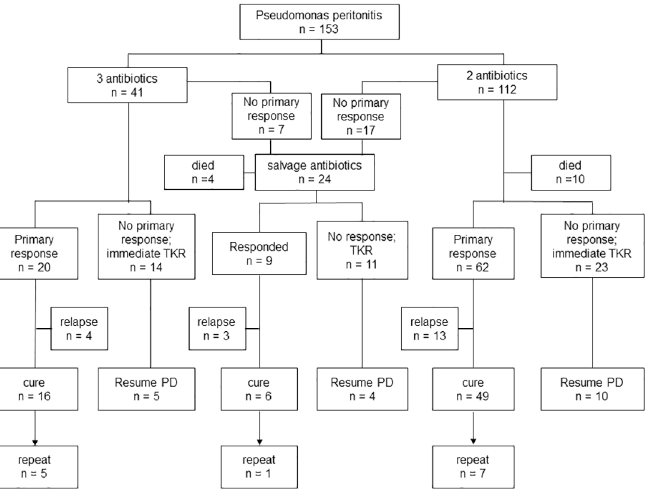
Fig 2. Summary of clinical outcome. (Abbreviations: TKR, Tenckhoff catheter removal; PD, peritoneal